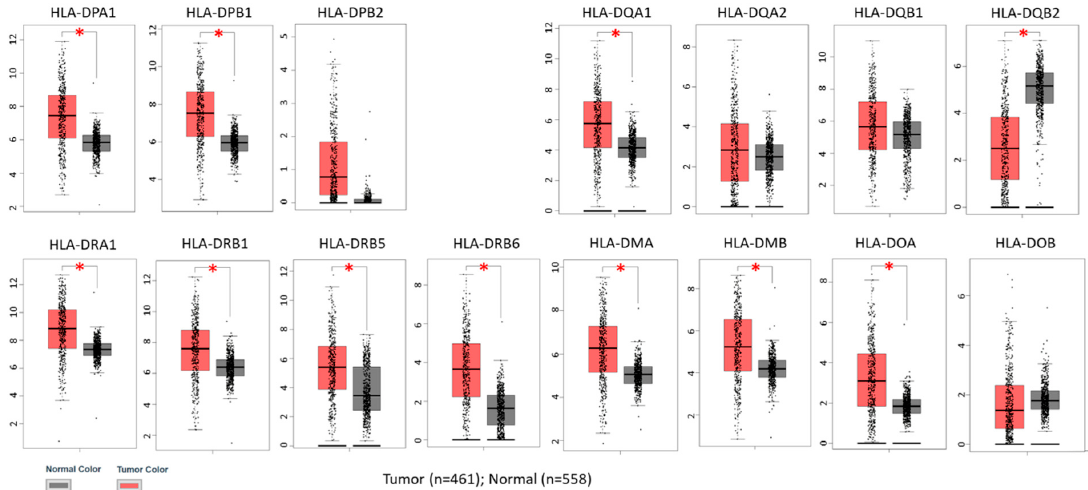
Figure 1. Expressions of human leukocyte antigen (HLA) class II genes in skin cutaneous melanoma from The Cancer Genome Atlas (TCGA) samples were compared with normal skin tissue from TCGA ( N = 1) and genotype-tissue expression (GTEx) ( N = 557) samples. Above results were obtained from the Gene Expression Profiling Interactive Analysis (GEPIA) database. The expression levels were expressed in log 2 (TPM + 1) scale. * Indicates p < 0.0001 between tumor and normal tissues.